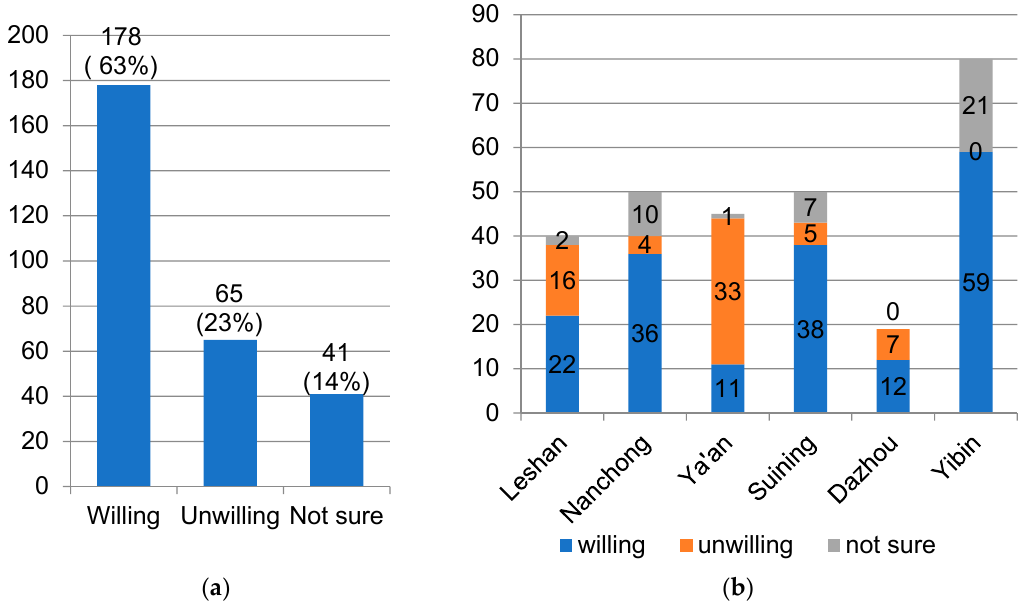
Figure 2. House owners’ willingness to participate in the vacant farmhouse market. ( a ) House owners’ willingness: total; ( b ) House owners’ willingness: different cities.